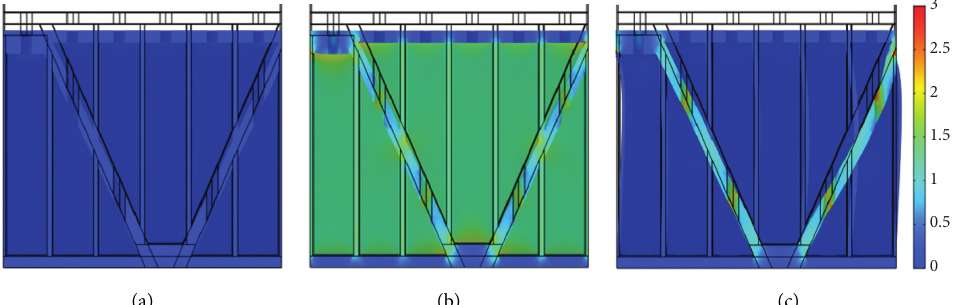
Figure 17: The steady-state stress distribution after being subjected to the same normal compressive strain. The deformation magnifies 3000